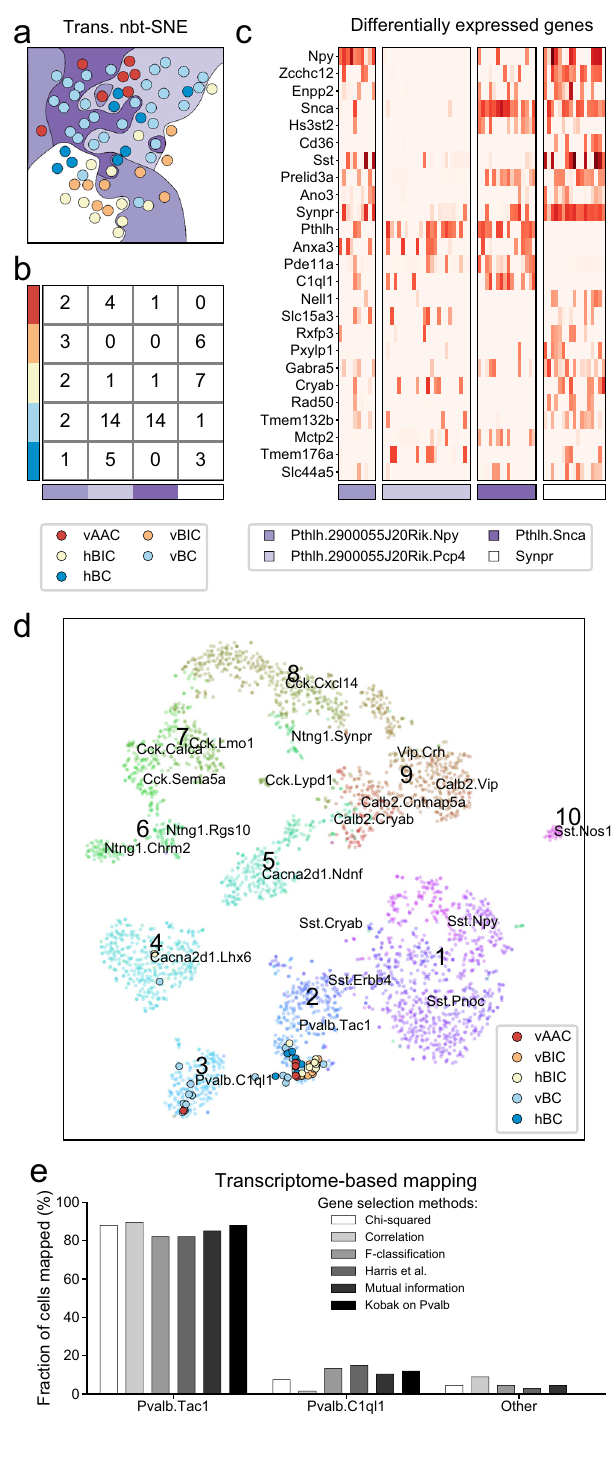
binomial t-SNE 10 ; Fig. 2a). Notably, these four transcriptional